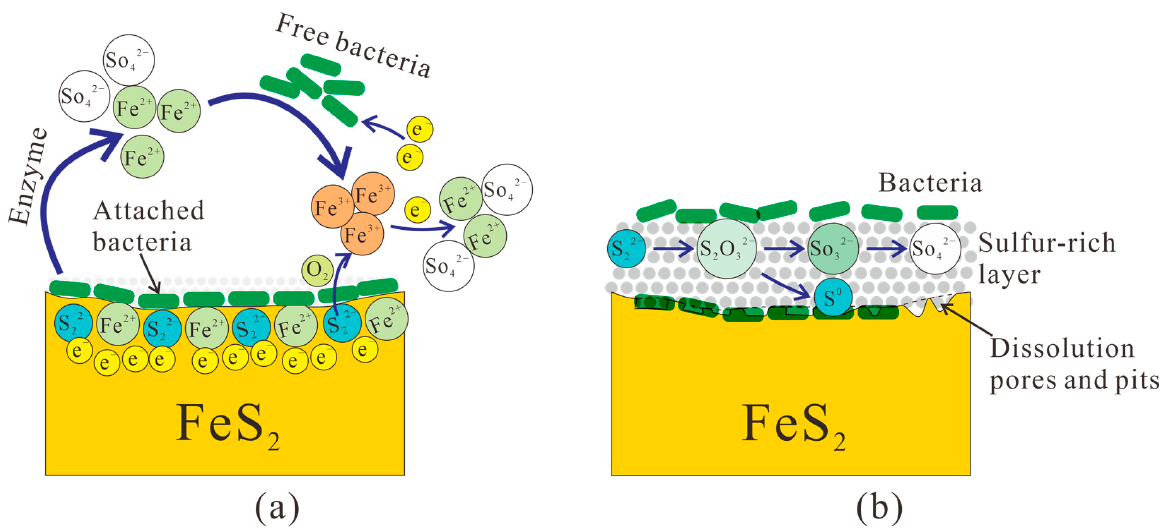
Figure 11. The mechanism of bacterial action on pyrite: ( a ) is the bacteria involved in pyrite oxidation process; ( b ) is the sulfur speciation changes on pyrite surface.